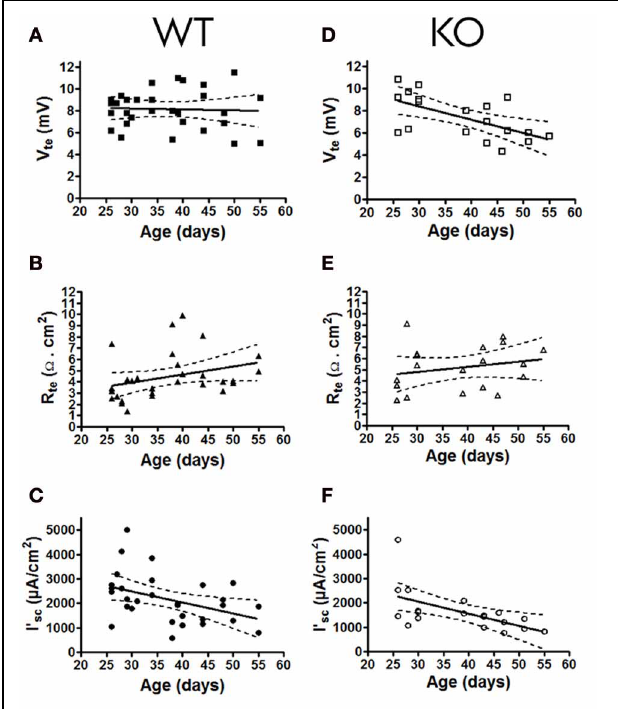
FIGURE 2 | Basal transport values (V te , R te , and I’ sc ) of mouse mTALs plotted as a function of age (in days) of P2Y 2 receptor WT (A, B, C; n = 30) and KO (D, E, F; n = 19) mouse. All 6 data panels include regression line fits where the stippled lines indicate the 95% confidence